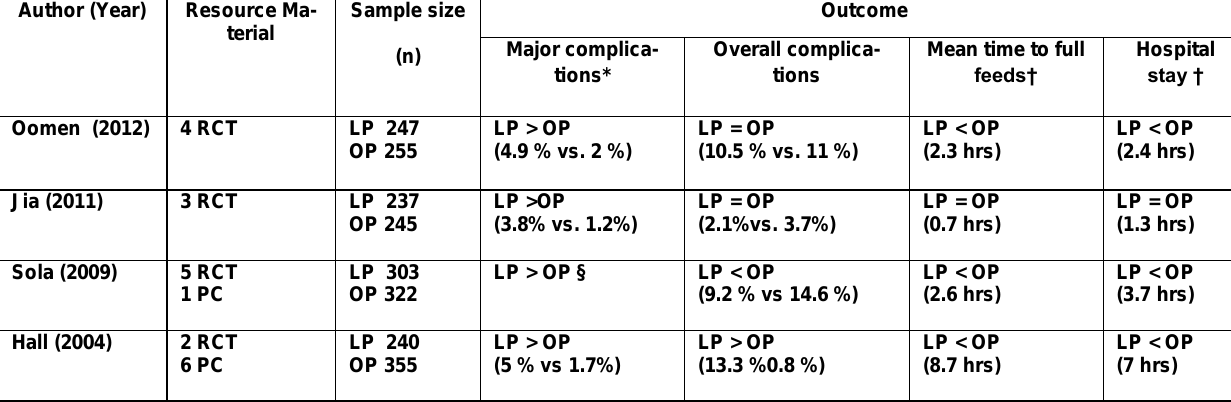
Table 1: Summary of Meta-analyses (2002 - 2012) on Laparoscopy versus Open